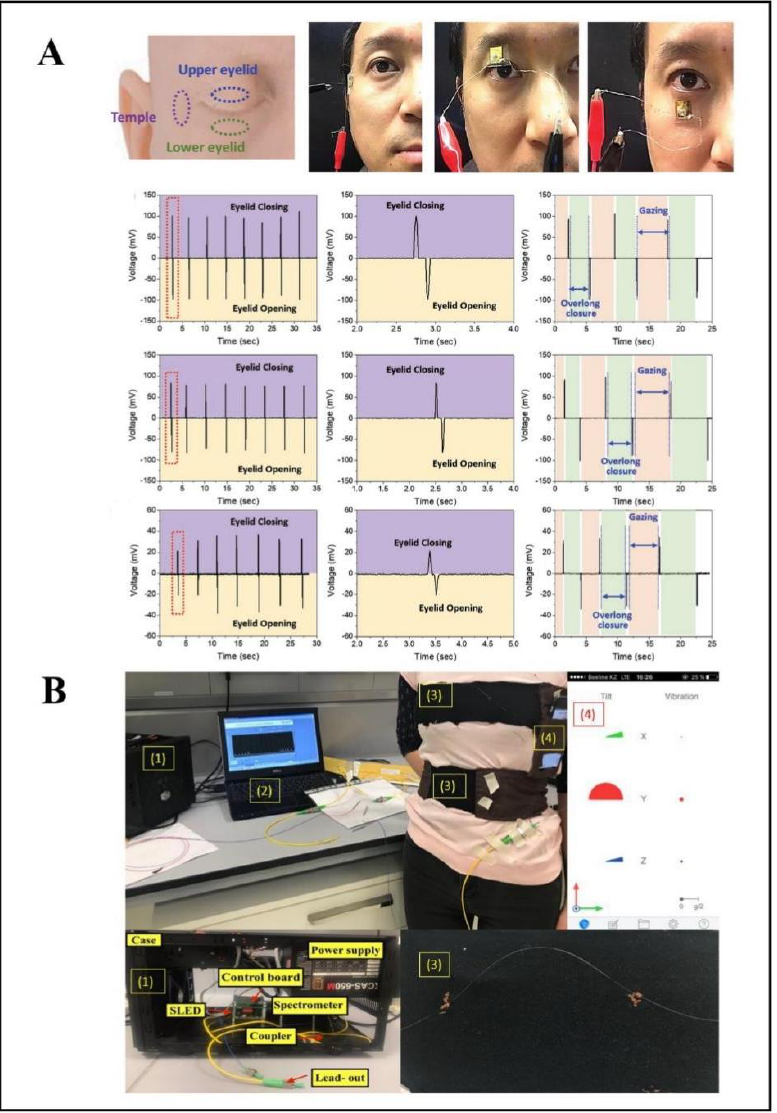
Figure 5. Examples of wearable flexible sensors for human motion and respiratory monitoring. ( A ) A noninvasive, and skin − attachable sensor using flexible piezoelectric thin film for monitoring the movement of the eye − blink, reprinted with permission from ref. [81]. Copyright 2021, Wiley. ( B ) A wearable system for respiratory monitoring with fiber-optic based smart textiles, (1) I-MON inter- rogator, (2) evaluation software, (3) belts equipped with an array of 5 FBGs, (4) VibSensor applica- tion. Reprinted with permission from ref. [89]. Copyright 2020,